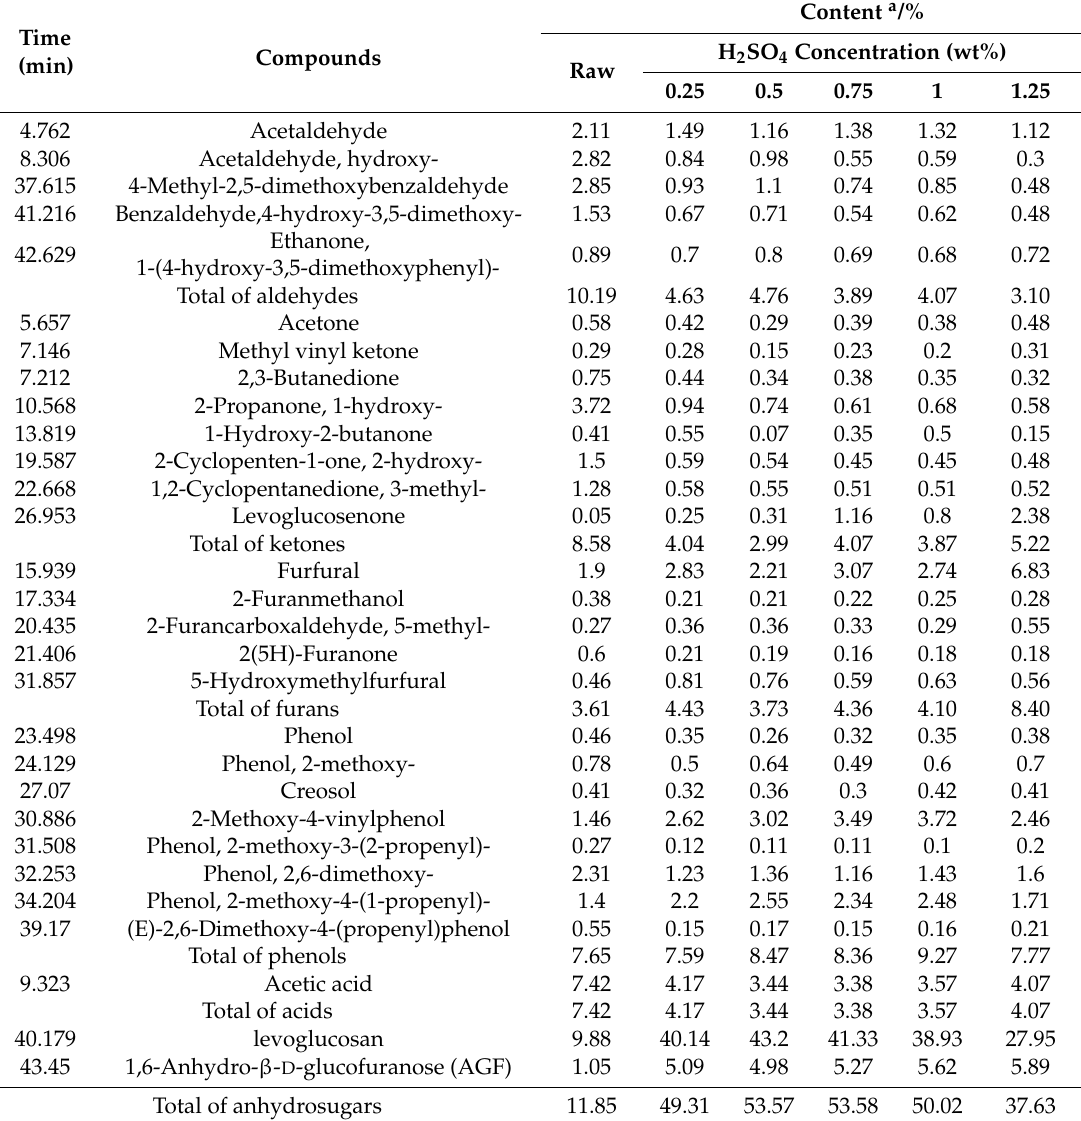
Table 3. The product distributions from fast pyrolysis of raw and H 2 SO 4 -impregnated